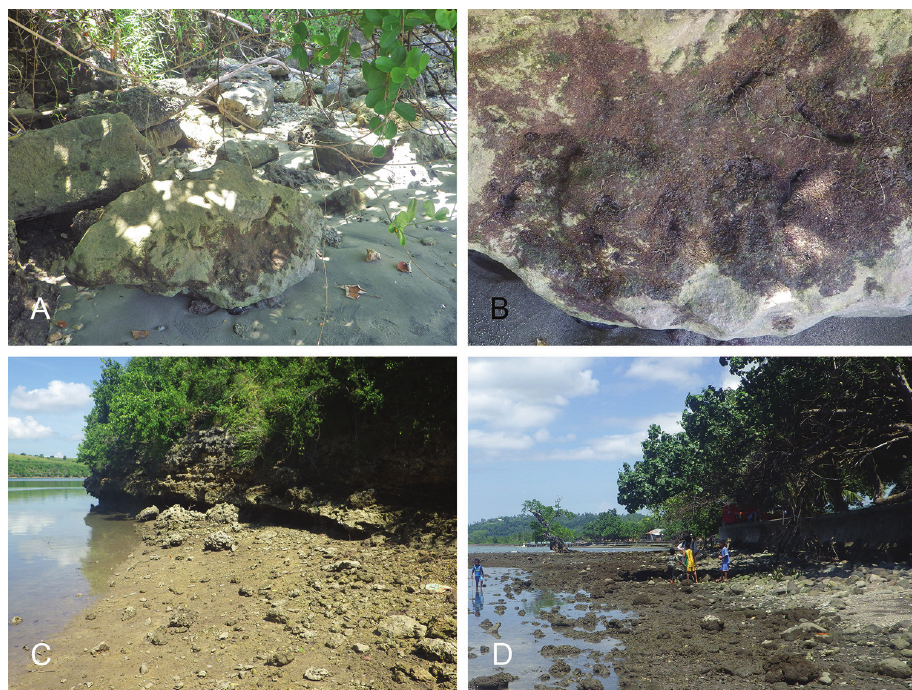
Figure 59. Habitats, Wallaconchis melanesiensis , Indonesia. A Halmahera, Foli, large rocks with algae high in intertidal (st 217) B Close-up of boulder showing the algae where the onchidiid was found (same locality as A) C Lombok, Seriwe Bay, narrow rocky beach between a cliff and the sea water D Halmahera, Sofifi, muddy, rocky intertidal (st